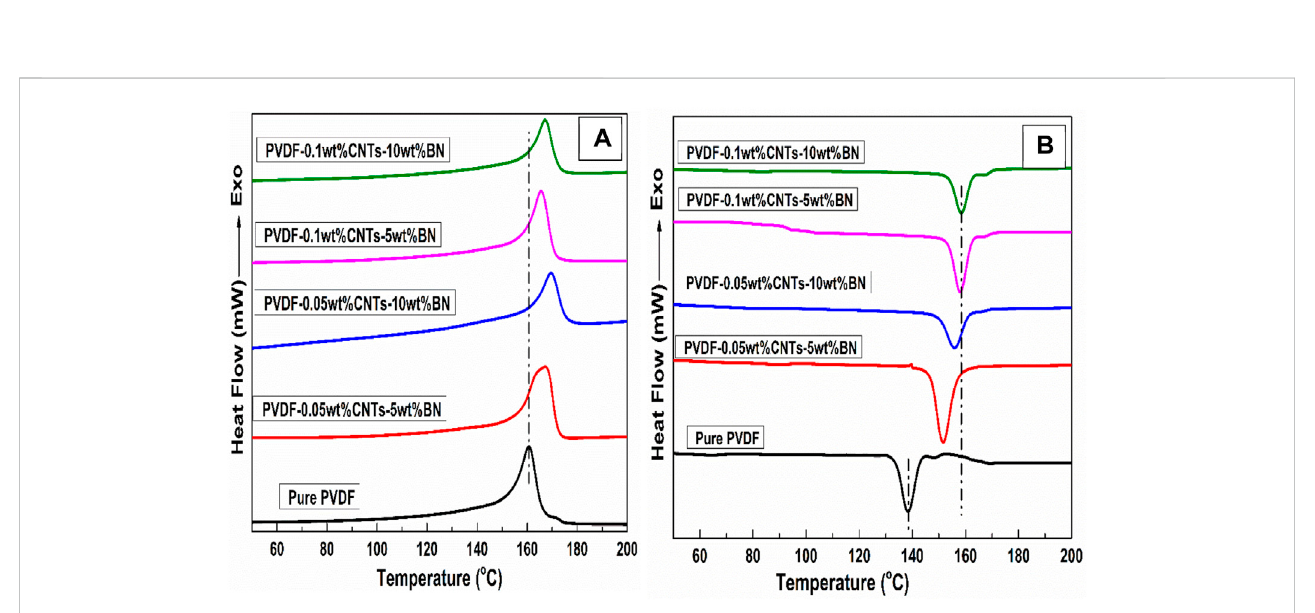
FIGURE 4 (A) Melting and (B) crystallization temperature of the